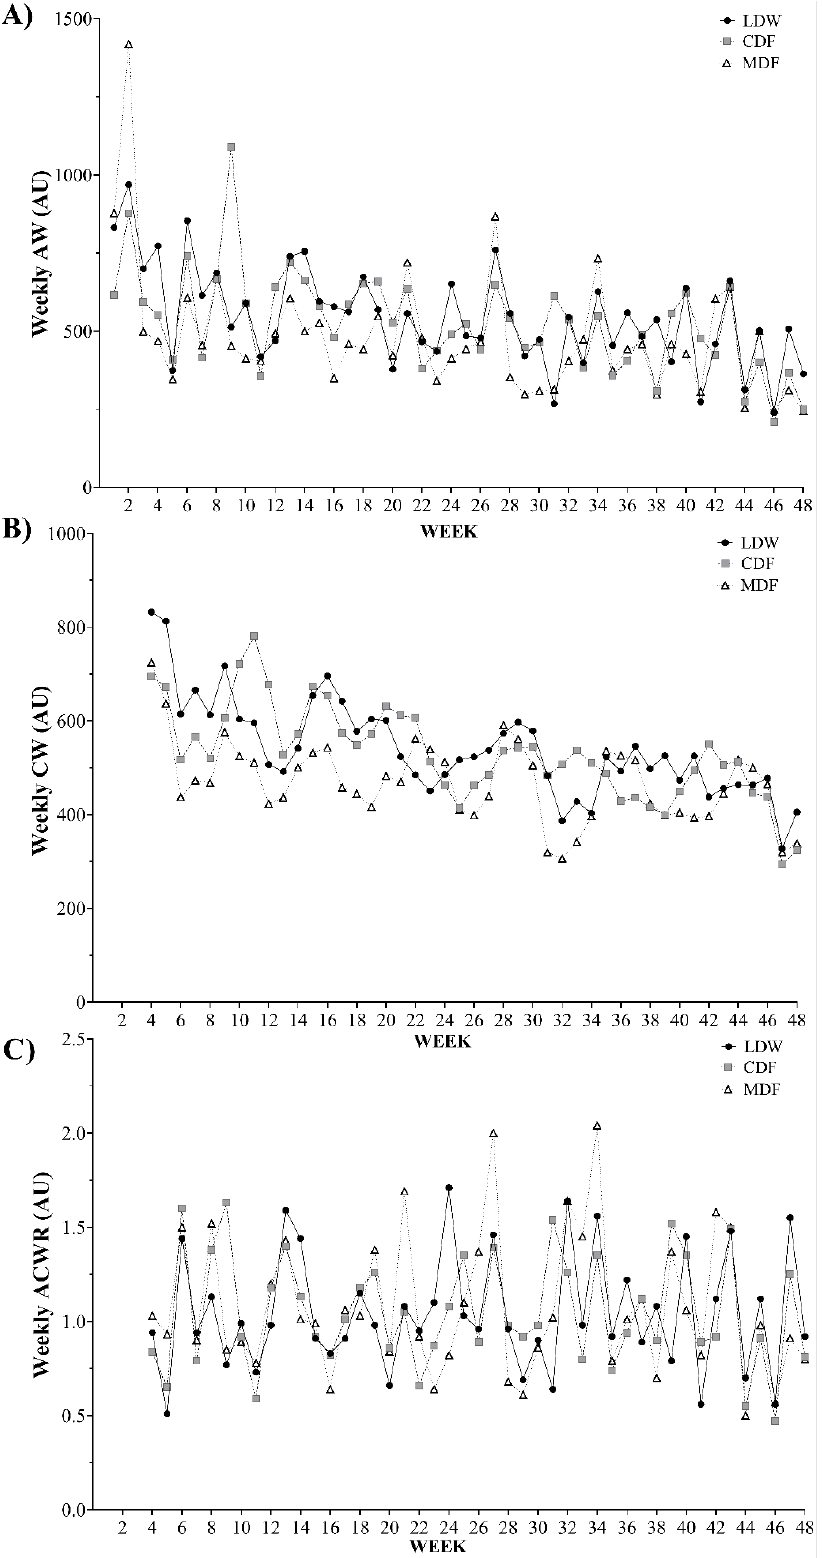
Figure 5. Descriptive statistics of ( A ) acute workload (AW), ( B ) chronic workload (CW), ( C ) acute: chronic workload ratio (ACWR), and their variations across the full season, considering the weekly averages of body load. AU, arbitrary units; LDW, lateral defenders and wingers; CDF, central defenders and forwards; and MDF, midfielders.